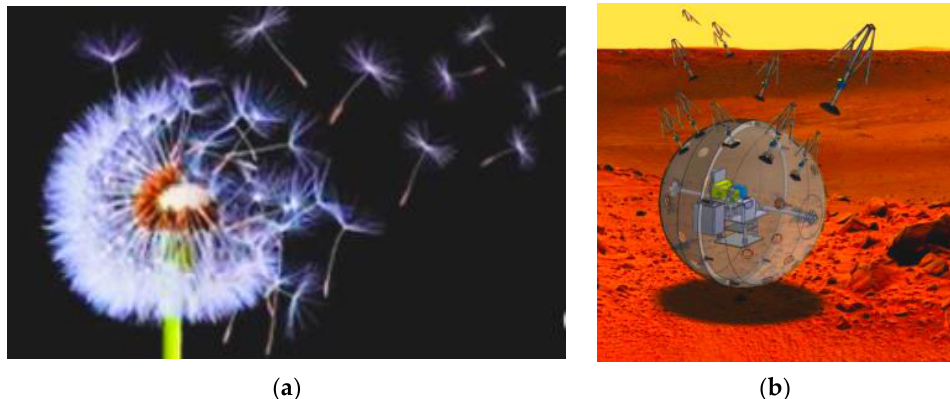
Figure 26. ( a ) The seeds of a dandelion being driven away by the wind ( b ) micro flying robots being detached from the spherical rover and being driven by the Martian wind [95]